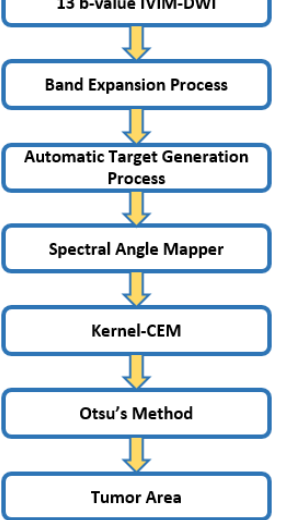
Figure 4. Flowchart of tumor detection via K-CEM.